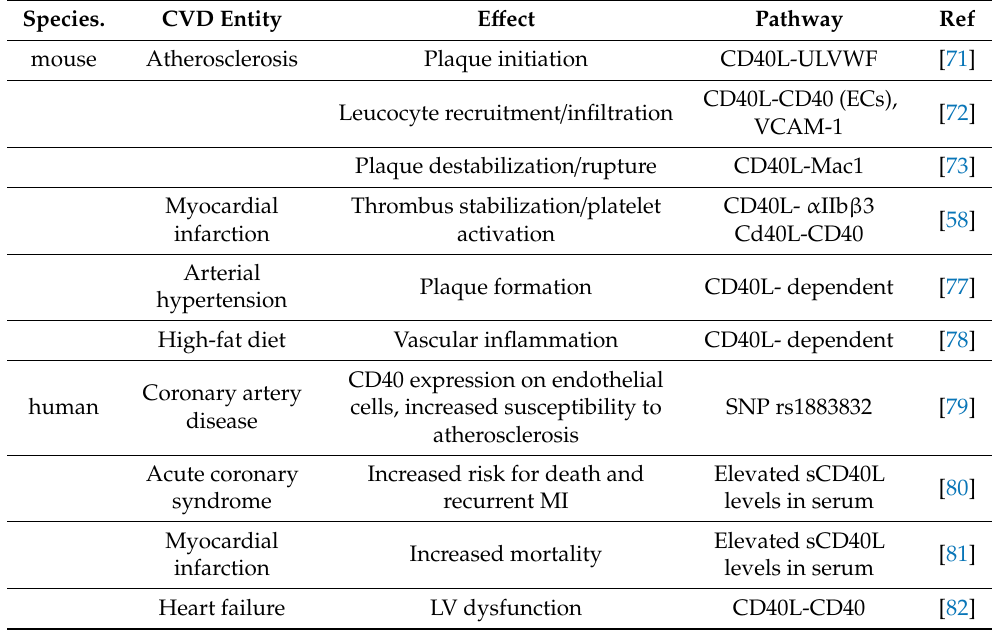
Table 1. Impact of CD40L–CD40 signaling on cardiovascular disease beyond atherosclerosis.